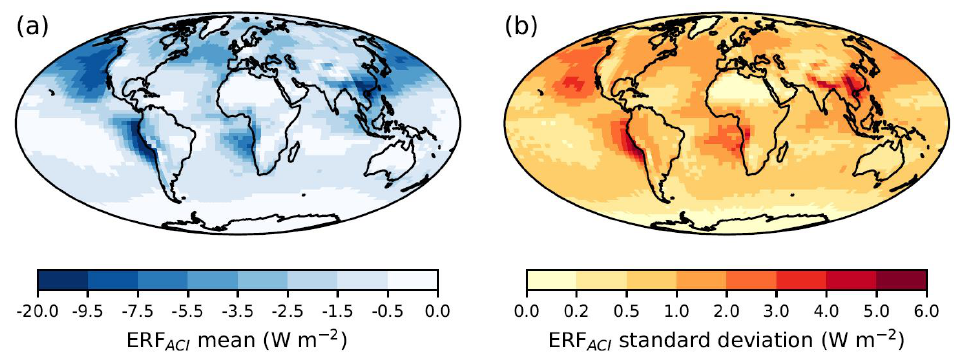
Figure 2. (a) Mean and (b) standard deviation for 1850–2008 ERF ACI forcing. Values were calculated using output from 270000 emulator- derived model variants at the individual pixel level once degraded to N48 model resolution. These samples of model variants are informed by the expert-elicited parameter pdfs.